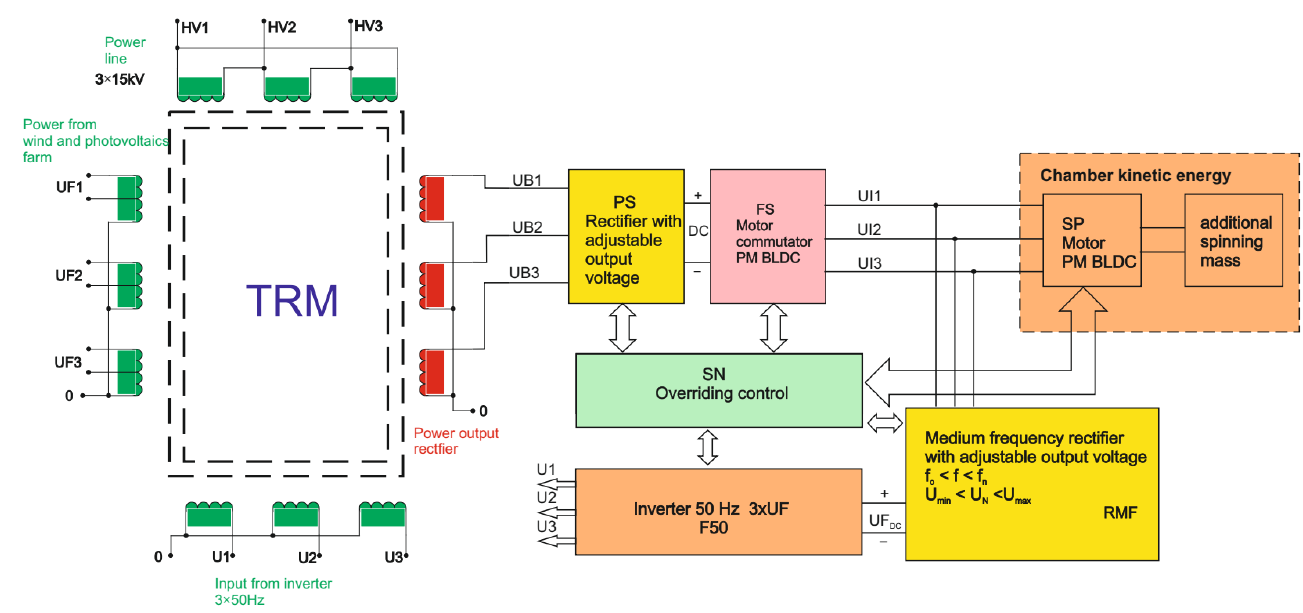
Figure 3. Block diagram of the energy recovery circuit/subsystem, claimed in the patent [ 4 ]. The synchronization circuit also makes it possible to add an offset of the synchronizing pulses with respect to the voltage waveform of a given phase. It should be noted that suitable control of the RMF rectifier (Figure 4), with the input voltage varying over its full operating range and the voltage frequency varying from some maximum to zero, that ensures maintaining constant output voltage for constantly vary- ing load current is itself a rather complicated